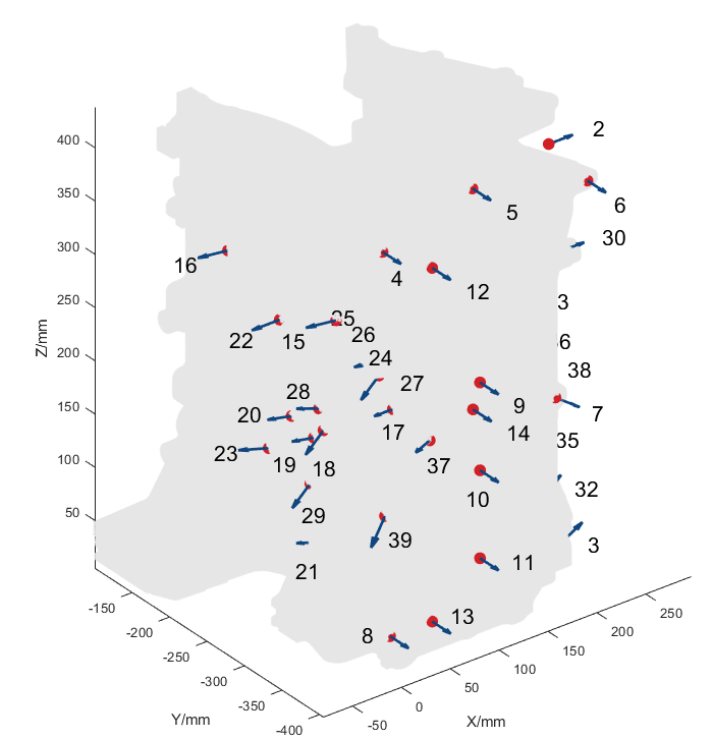
Figure 10. MP layout on the cylinder block.